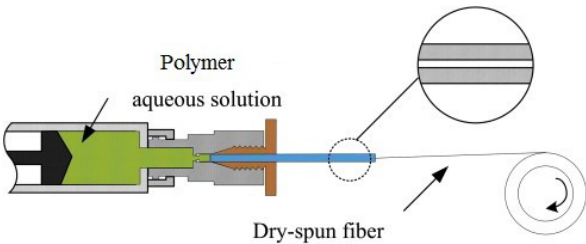
Figure 3: Dry-spinning process